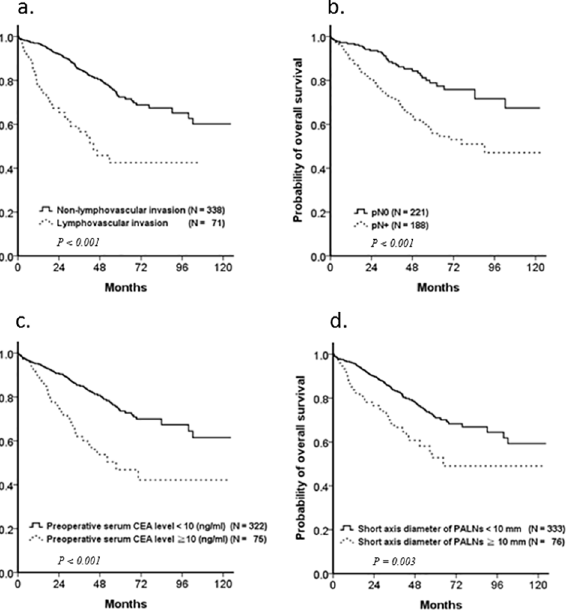
Fig 3. Prognostic factors for overall survival (OS) in patients with visible PALNs. Kaplan – Meier plots revealed that (a) lymphovascular invasion ( P < 0.001), (b) pN stage ( P < 0.001), (c) preoperative serum CEA level ( P < 0.001), and (d) short axis diameter of PALNs ( P = 0.003) were independent prognostic factor in patients with visible PALNs.